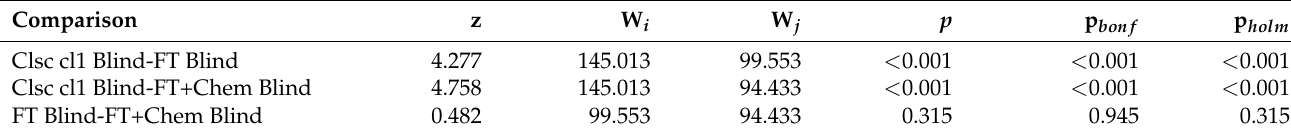
Table 6. Dunn post-hoc test for the RMSD distributions between the benchmarking protocols on the Astex benchmarking